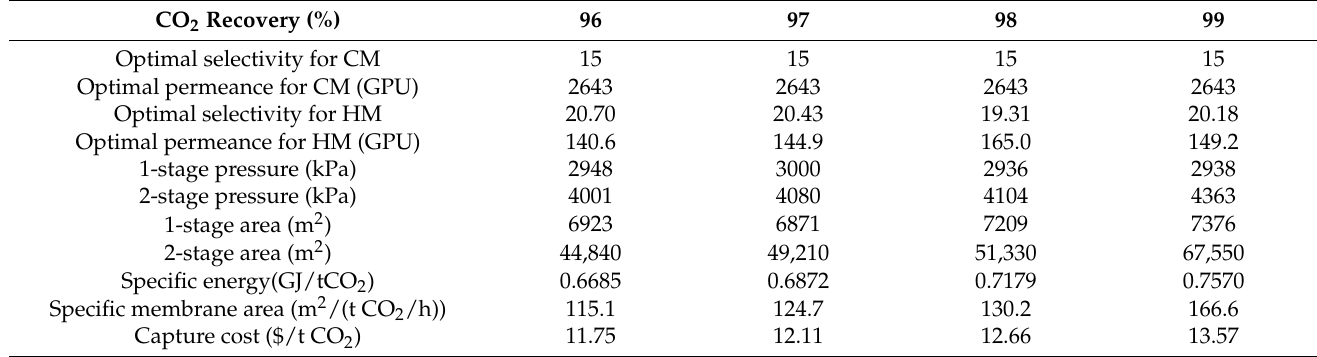
Table 7. Information of the optimal process of increasing CO 2 purity when the H 2 -selective and CO 2 -selective membranes change based on the Robeson upper